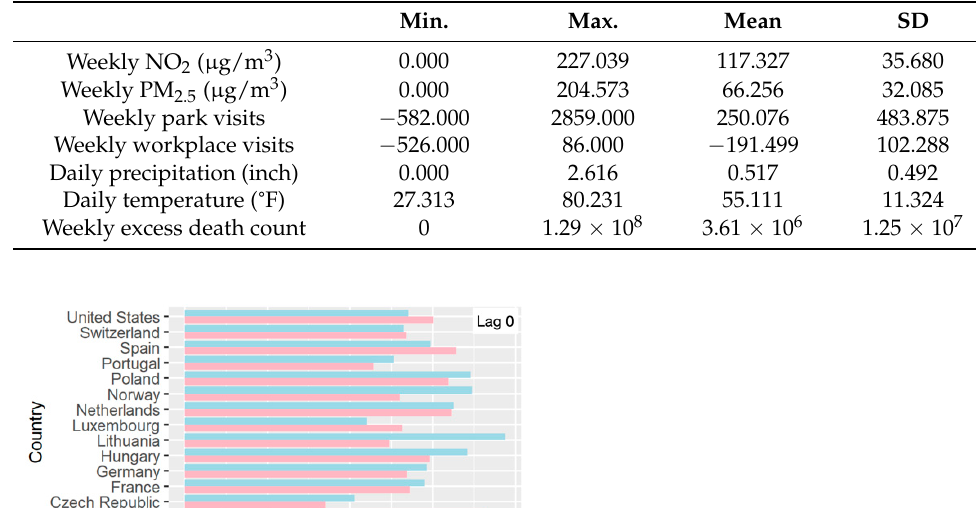
Table 2. Summary of ground-level air pollution data, human activity data, meteorological data, and excess all-cause mortality.